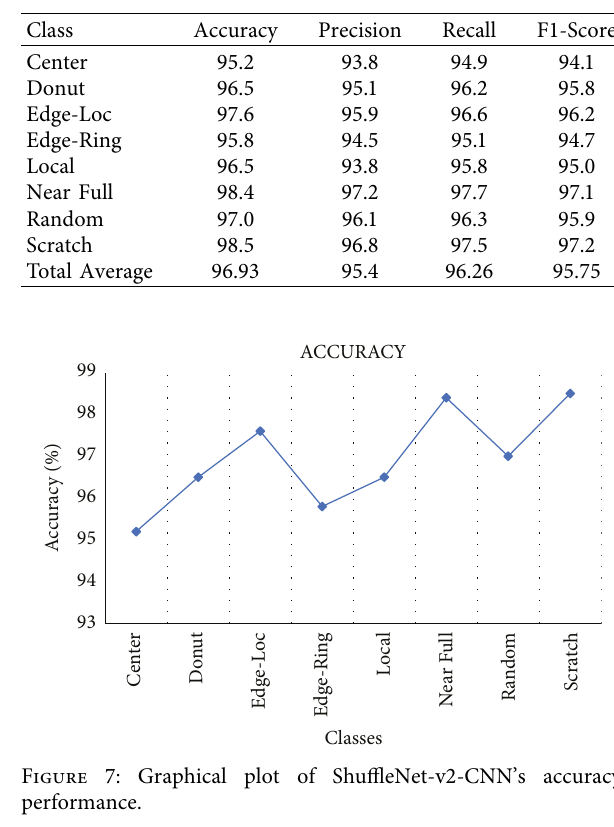
Figure 6: Sample images from the WM-811K dataset [25]. Table 3: Performance analysis of proposed ShuffleNet-v2-CNN model.